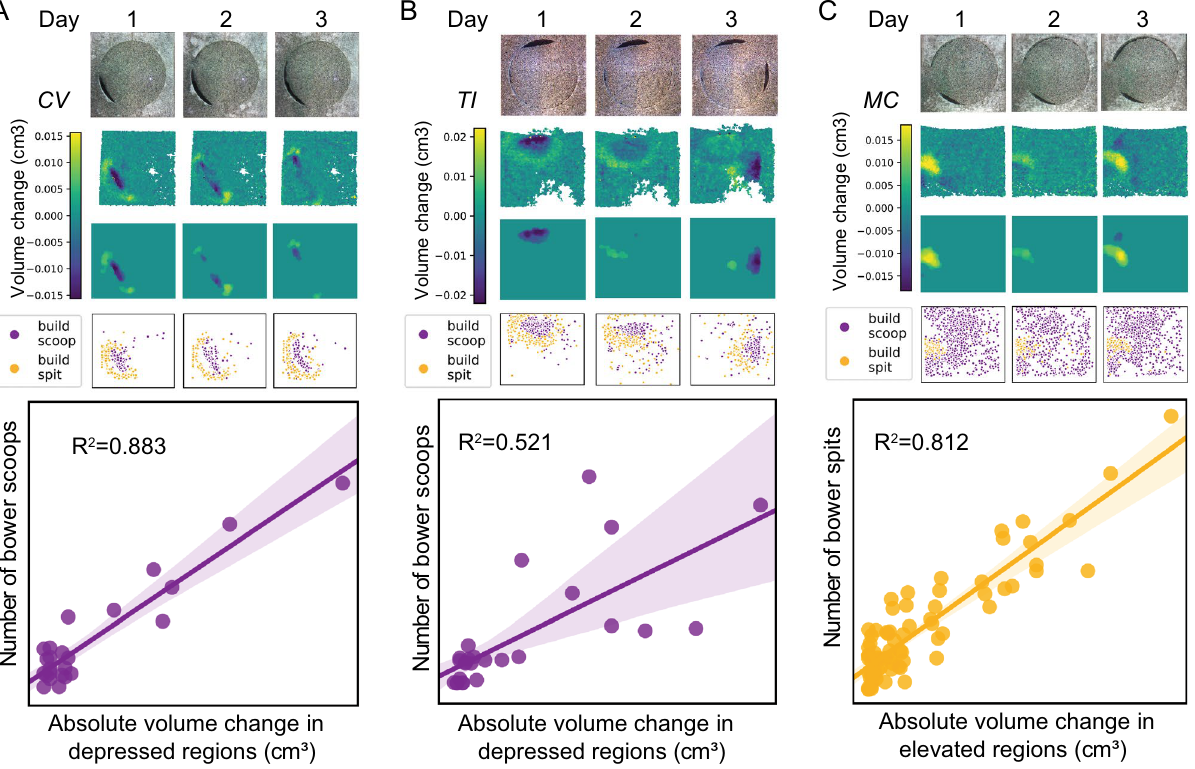
Figure 4. CNN-predicted construction behaviors are strongly correlated with bower structure. RGB images collected with the Kinect (first row, ( A – C )) were registered to RGB frames collected with the Raspberry Pi Camera to spatially align video and depth data. Daily depth change data (second row, ( A – C )) was analyzed to identify above-threshold regions (third row, ( A – C )). In pit-diggers ( A , B ), a greater proportion of CNN- predicted bower scoops versus bower spits mapped onto extreme height change regions (overlap of third and fourth rows), whereas in castle-builders the reverse was true: a greater proportion of bower spits versus bower scoops mapped onto extreme height change regions. In pit-diggers, the number of bower scoops per hour was strongly and positively correlated with the total volume change in that hour (e.g. see representative regression plots for individual trials in ( A , B ), whereas in castle-builders the number of bower spits per hour was strongly and positively correlated with the total volume change in that hour (regression plot, ( C )).